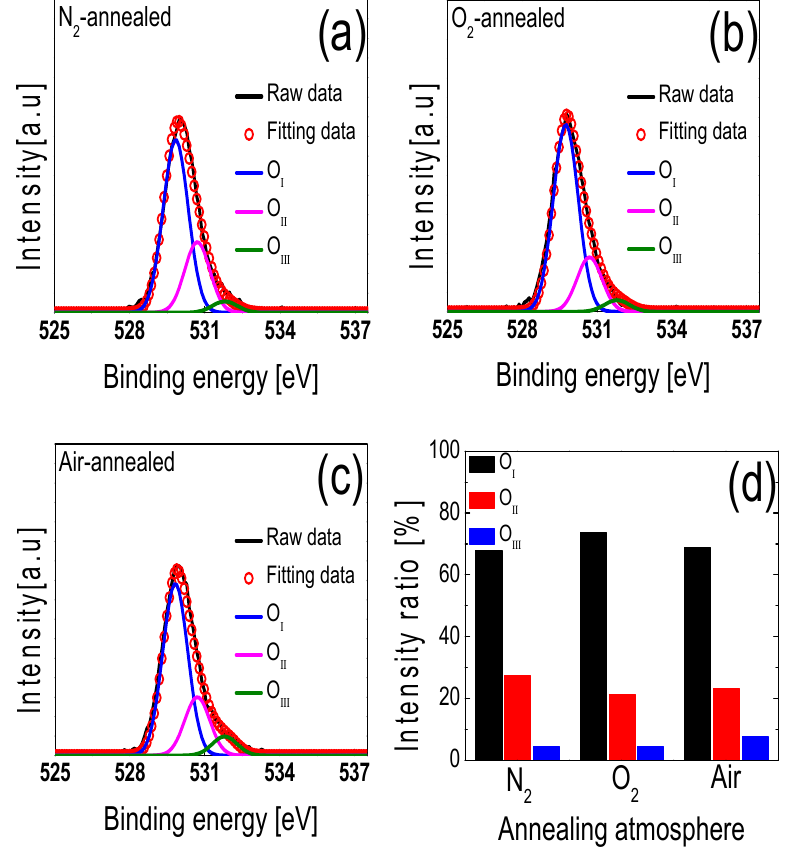
Figure 7. X-ray photoelectron spectroscopy (XPS) O 1 s spectra of ( a ) N 2 -, ( b ) O 2 -, and ( c ) air annealed IGTO thin films, respectively, recorded for the middle of the thin films. ( d ) Relative areas of the O I , O II , and O III peak regions that were obtained for the IGTO thin films annealed under different atmospheres.